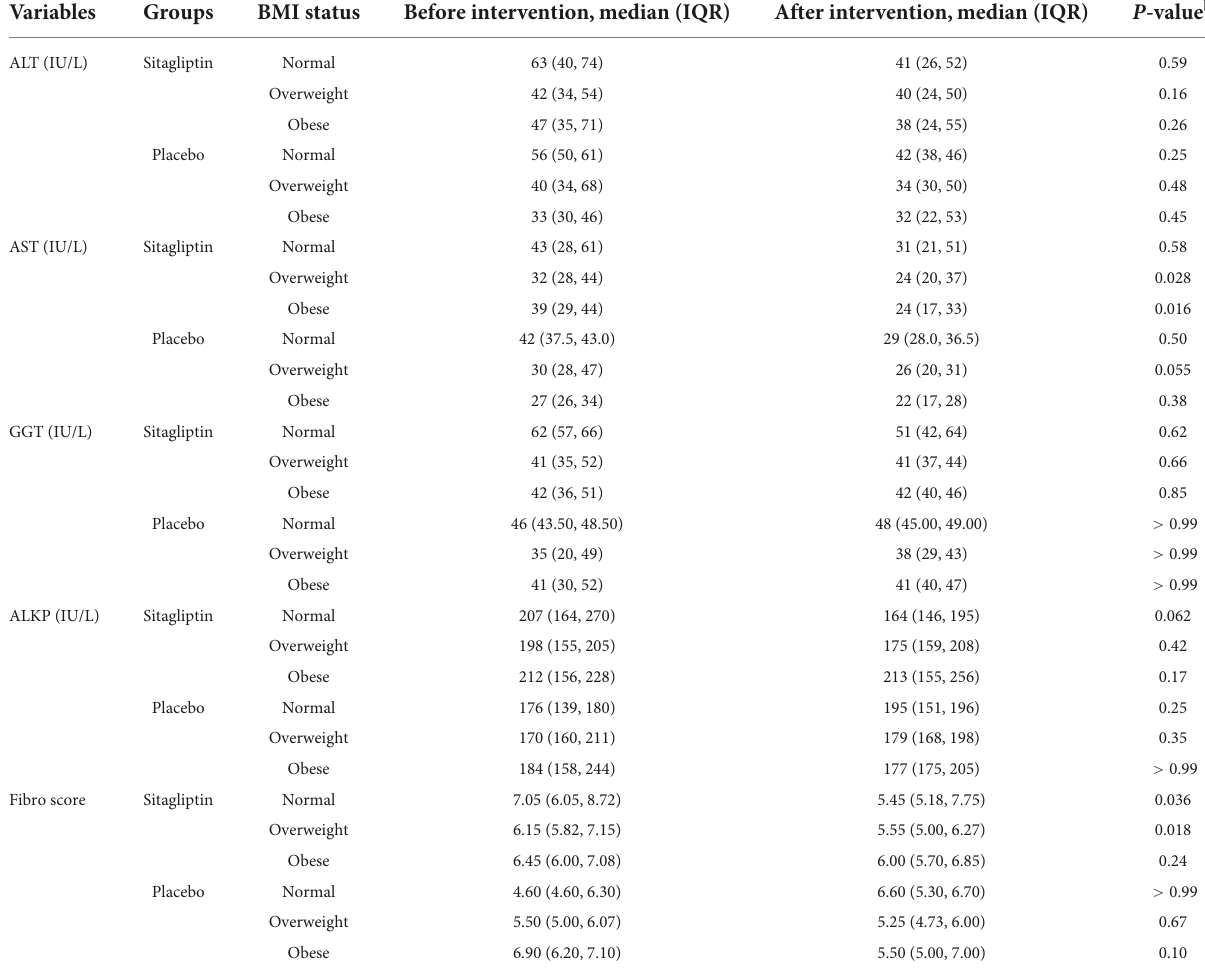
TABLE 3 Changes in outcome in the treatment group ( n = 44) and placebo group ( n = 32) based on the BMI status.